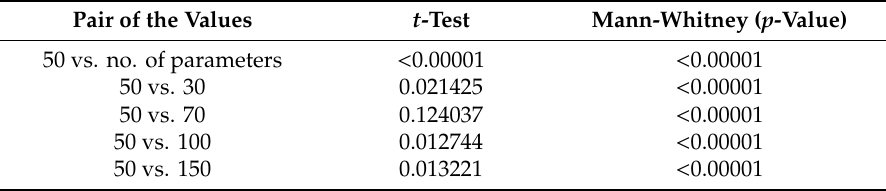
Table 4. Statistical comparison between population size 50 and the